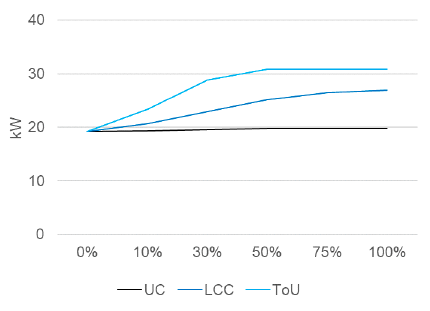
Figure 13. Development of the building’s peak volume demand.